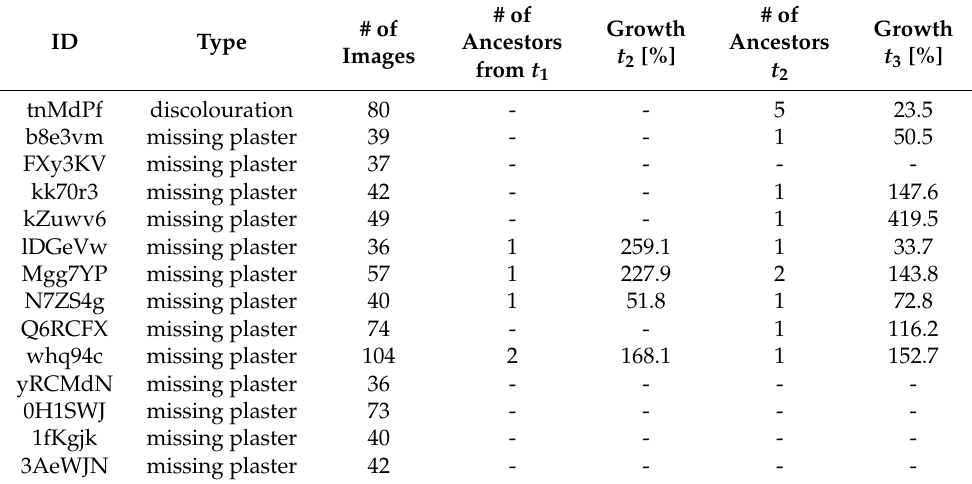
Table 2. Results of the assignment and comparison workflow for Wall 02, showing the amount of assigned images and the computed percentage damage